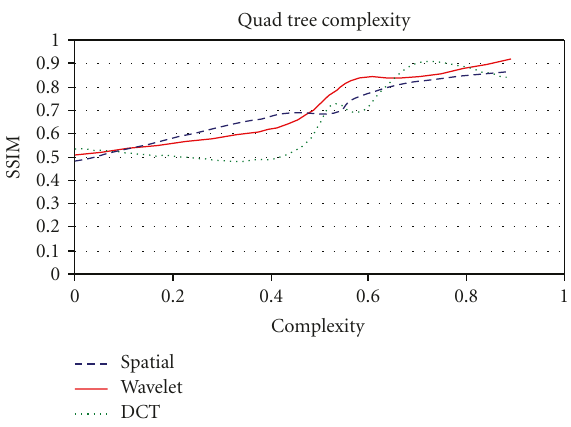
Figure 4: Relation between SSIM and Quad tree complexity measure (averaged on 2000